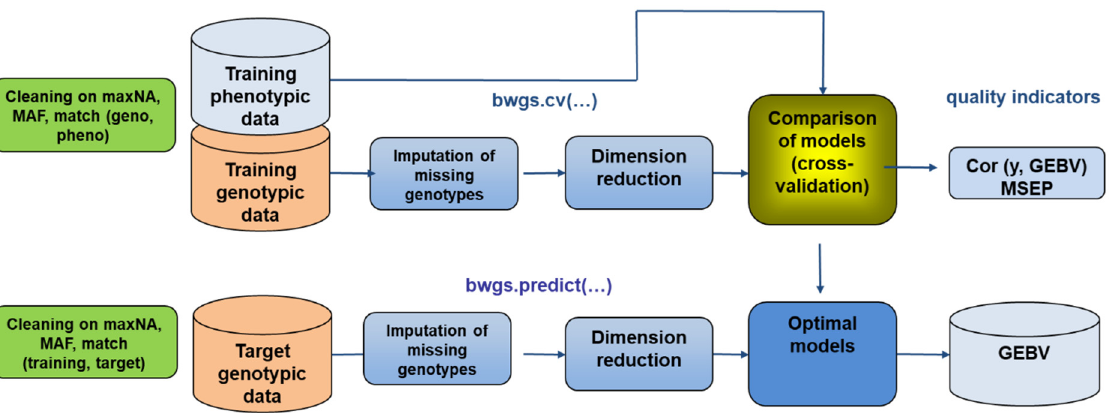
Figure 5. Workflow of the two main functions of the BREEDWHEAT Genomic Selection (BWGS) software. Function bwgs.cv() derives model cross-validation on a training set and function bwgs.predict() conducts model calibration on a training set and GEBV prediction of a target set of genotypes. MAF: minor allele frequency, maxNA: maximum % of marker missing data, MSEP: mean square error of prediction, GEBV: genomic estimated breeding value.